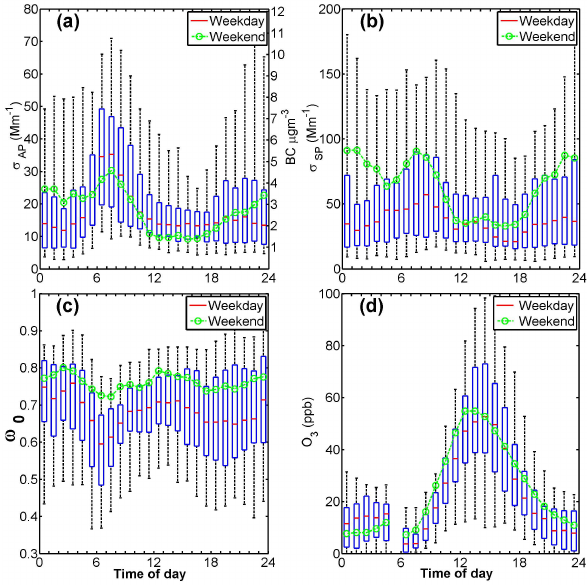
Fig. 4. The diurnal cycle of aerosol optical properties and O 3 . Diur- nal weekday cycle of (a) light absorption coefficients and BC mass concentrations (on the right y-axis), (b) light scattering coefficients, (c) single-scattering albedo at 637nm and (d) ozone (O 3 ) concen- trations. The edges of the blue boxes represent the 75th and 25th percentiles and the black whiskers the 95th and 5th percentiles. Weekday diurnal median values are in red and weekends in